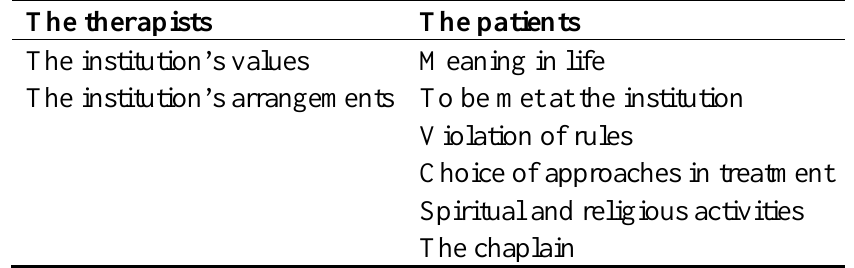
Table 1. Central themes arising from the content analysis among therapist and